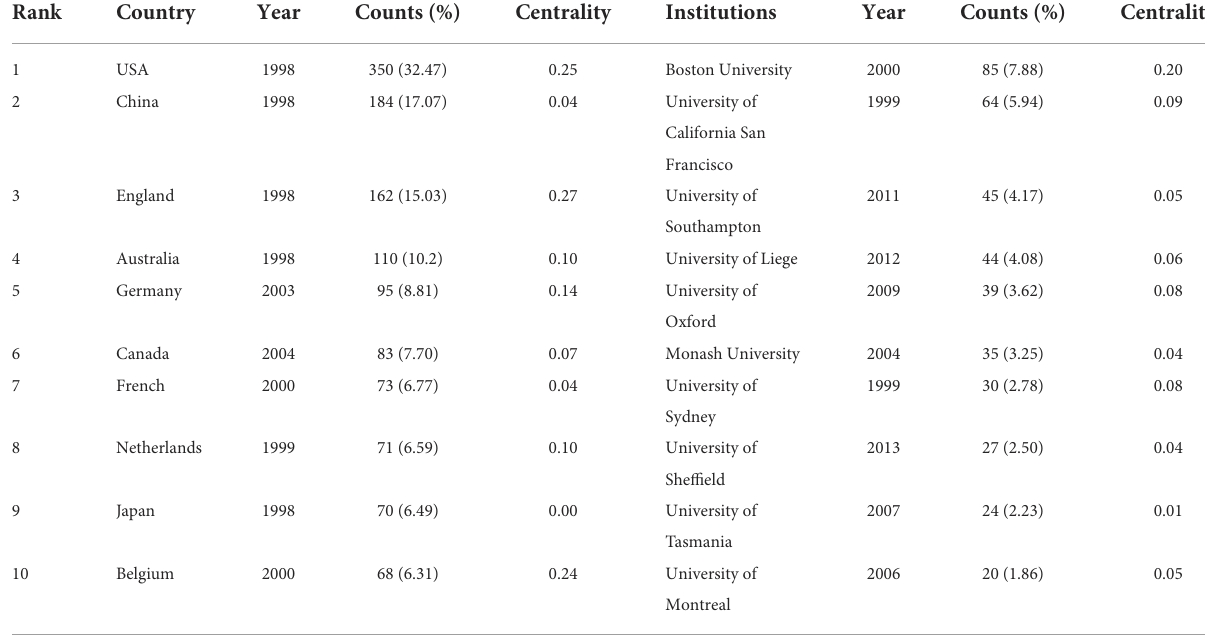
TABLE 2 Publications in the 10 most productive countries/regions and